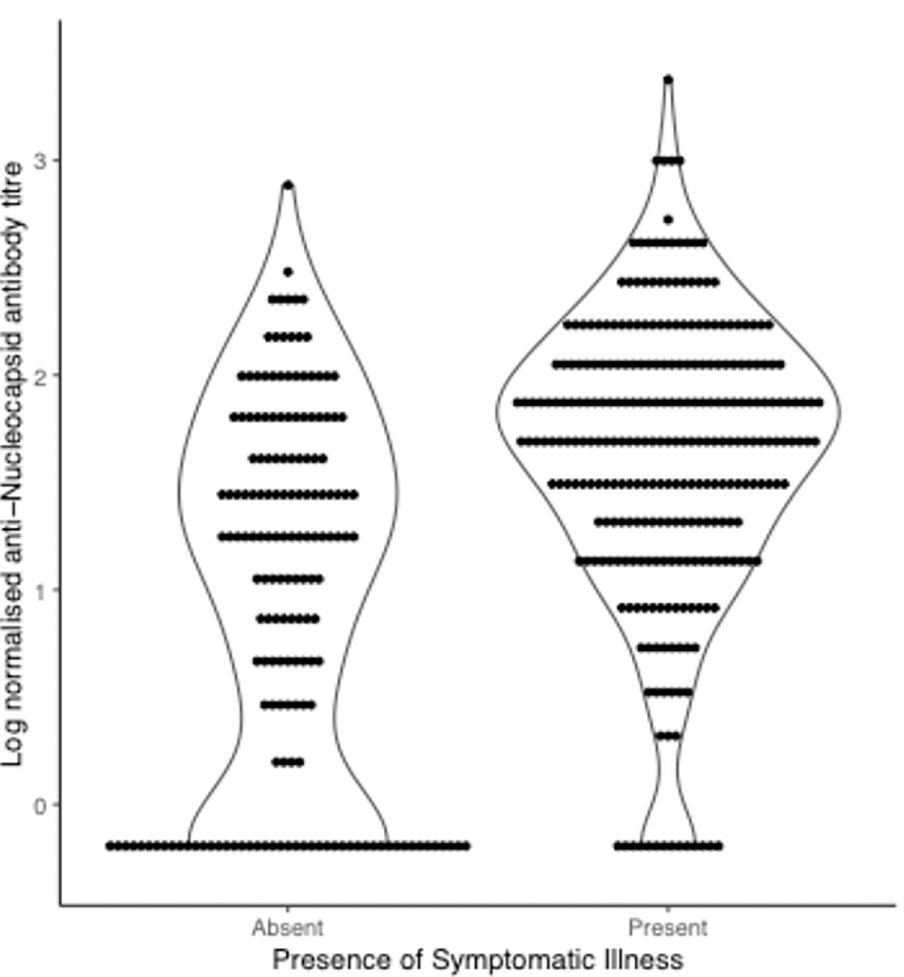
Fig 2. Magnitude of anti-nucleocapsid SARS-CoV-2 antibody response in 454 household contacts with and without reported COVID symptoms. https://doi.org/10.1371/journal.pone.0284372.g002 This contrasts with previous published work where nucleocapsid titre declines more rapidly over the first 6 months from infection than Spike protein titre but does not impact positivity overall.